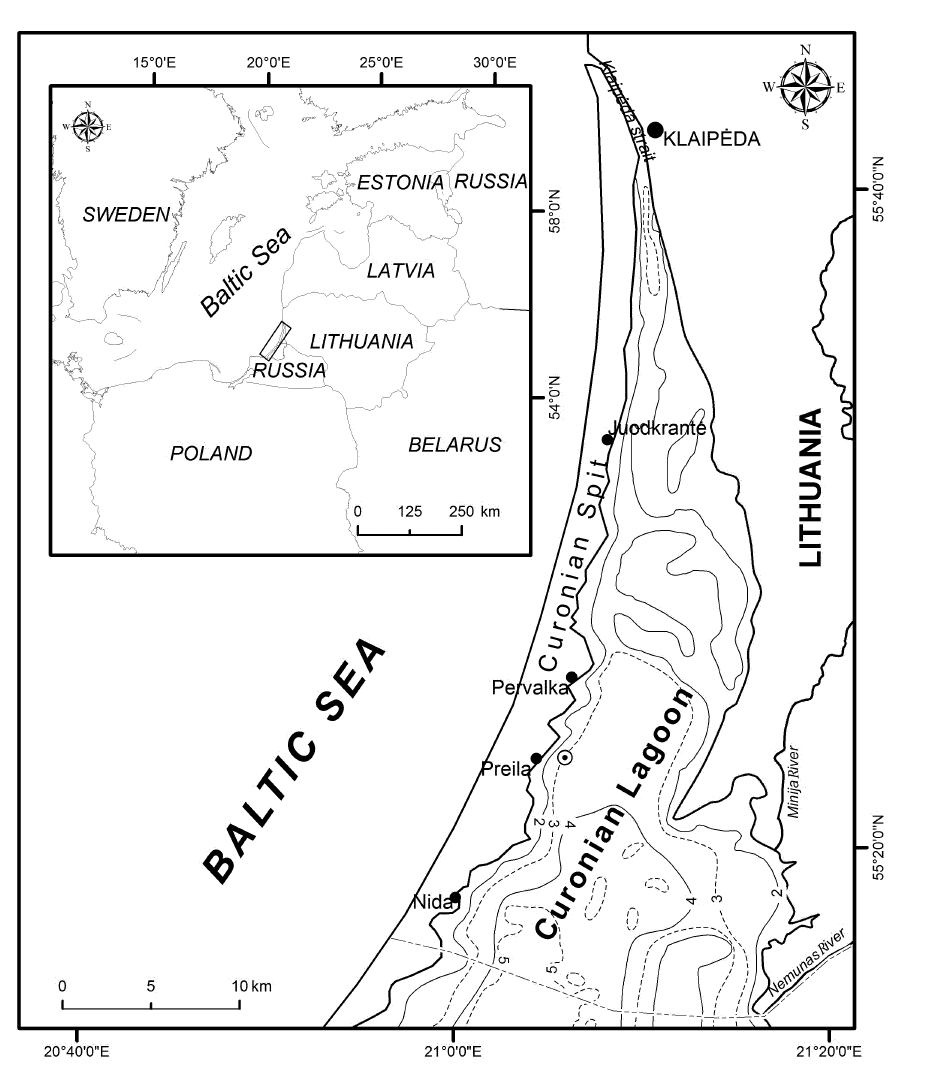
Fig. 1. Location of the investigated sediment